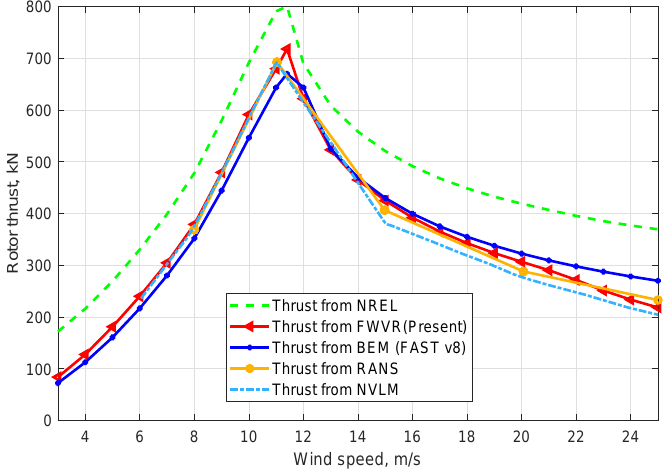
Figure 6. The thrust of monopile NREL 5 MW wind turbine as a function of the wind speed.